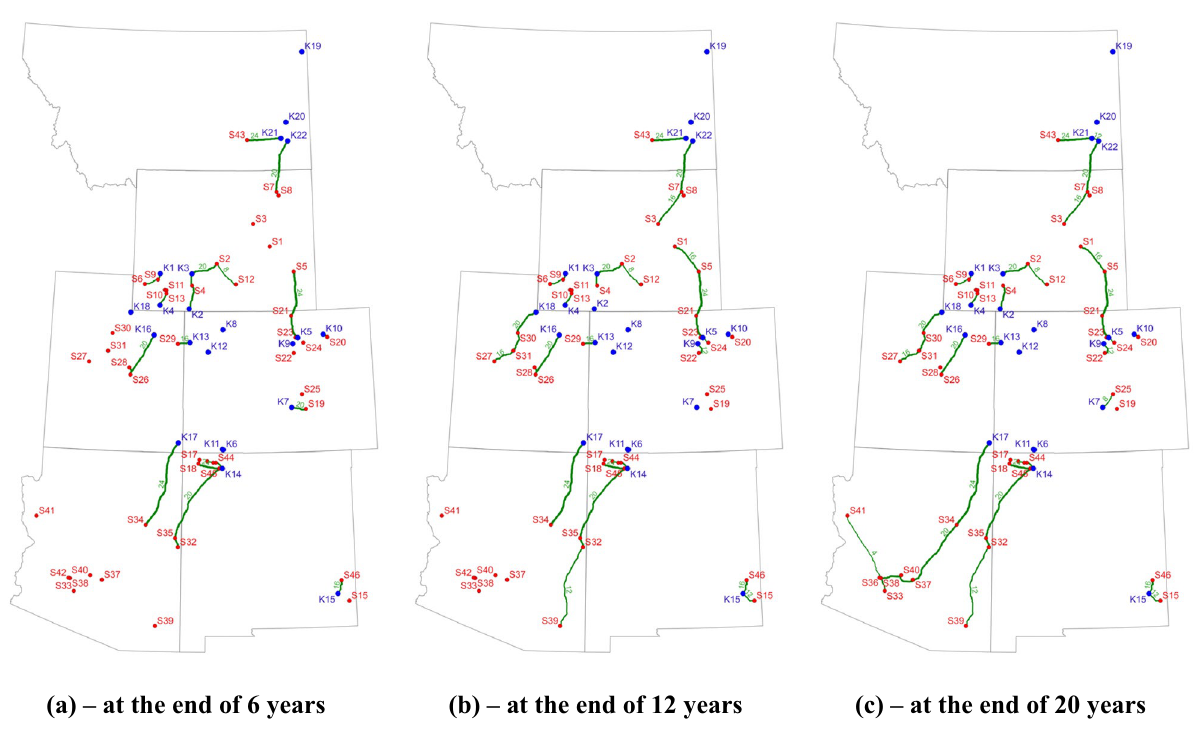
Figure 10. Evolution of pipeline construction for the I-West case: ( a ) at the end of year 6; ( b ) at the end of year 12 and ( c ) at the end of year 20. The green curve denotes the optimized pipeline route, and the thickness of the curve and the number on the curves represent the pipeline sizes (diameter); the red dots represent source location, while the blue dot indicates sink location.